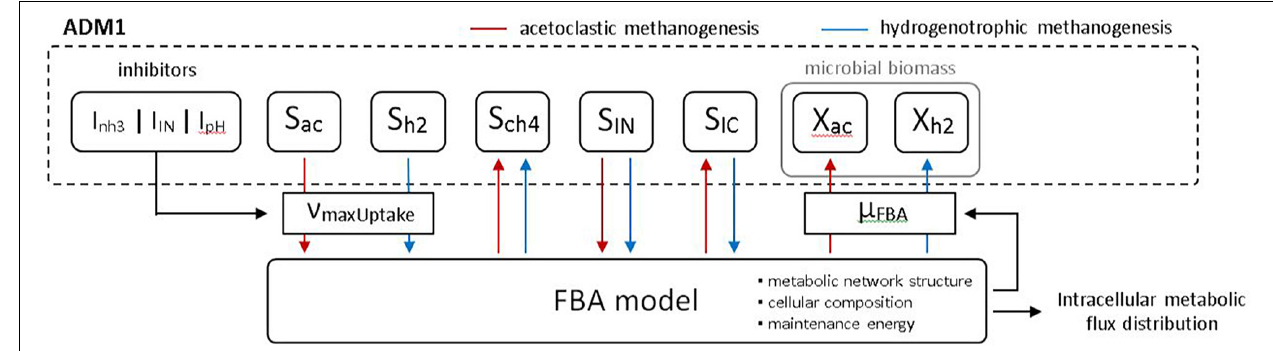
FIGURE 1 | Coupling concept of the augmented model. ADM1 state variables for acetate (S ac ) and hydrogen (S h2 ) are used to define maximal allowable uptake fluxes for the methanogenic FBA model, taking into account ADM1 inhibitory processes. The FBA model predicts the current specific growth rate µ FBA which is used to update respective biomass state variables in ADM1. Predicted uptake and release fluxes are likewise used to update ADM1 state variables. In addition, the FBA model provides predictions for all intracellular fluxes.